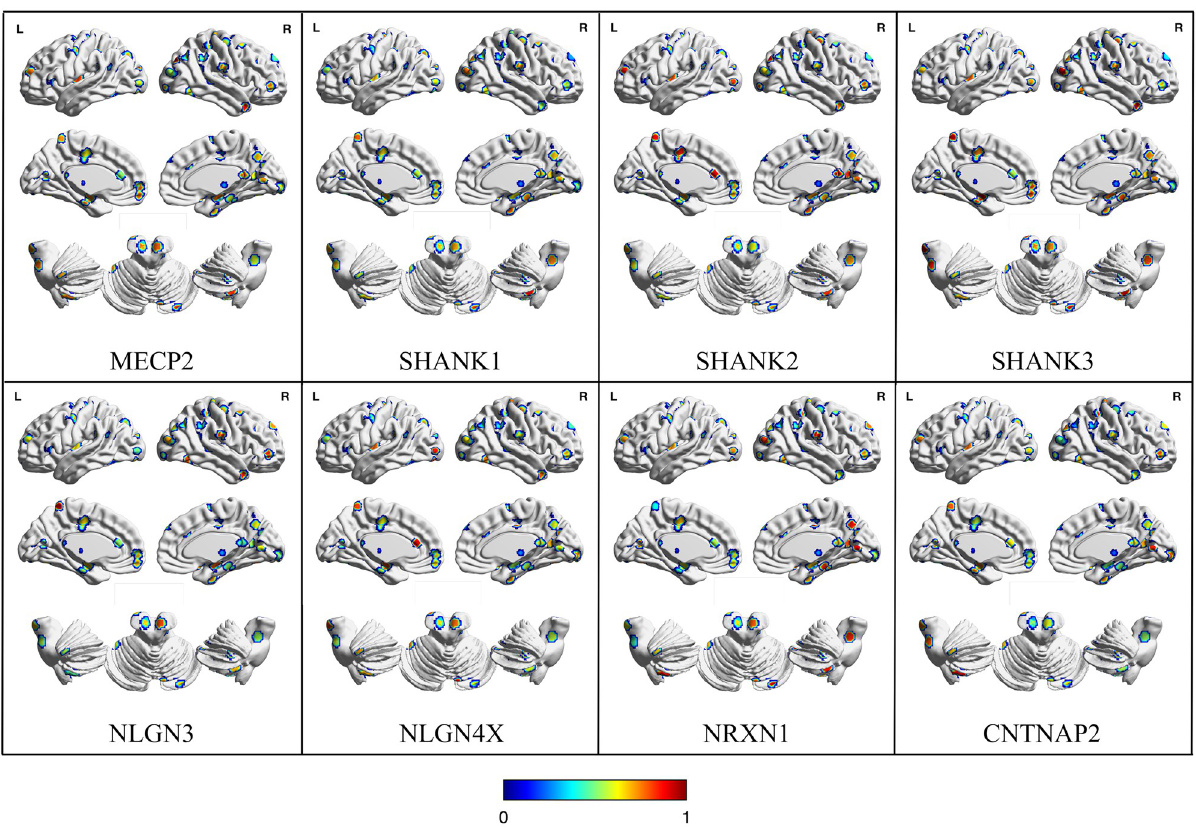
Fig 1. Map with the correlation between gene expression and ALE-derived gray matter decrease of each cluster. SMN: Sensorimotor Network, DAN: Dorsal Attention Network, VAN/SN: Ventral Attention/Salience Network, DMN: Default Mode Network, BG/Thal: Basal